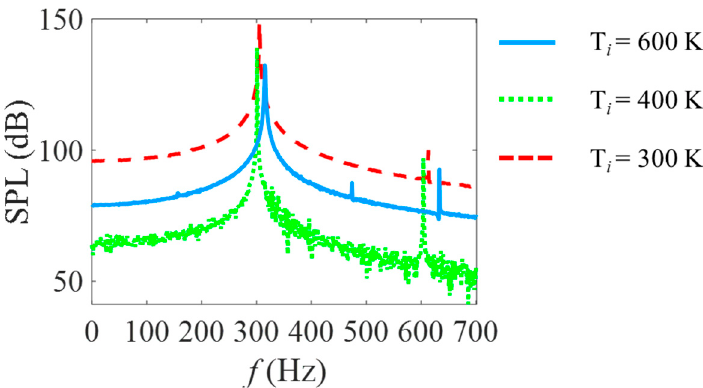
Figure 12. Frequency spectrum of acoustic pressure fluctuations of different T i at S N = 0.6 and V a = 180 L/min.